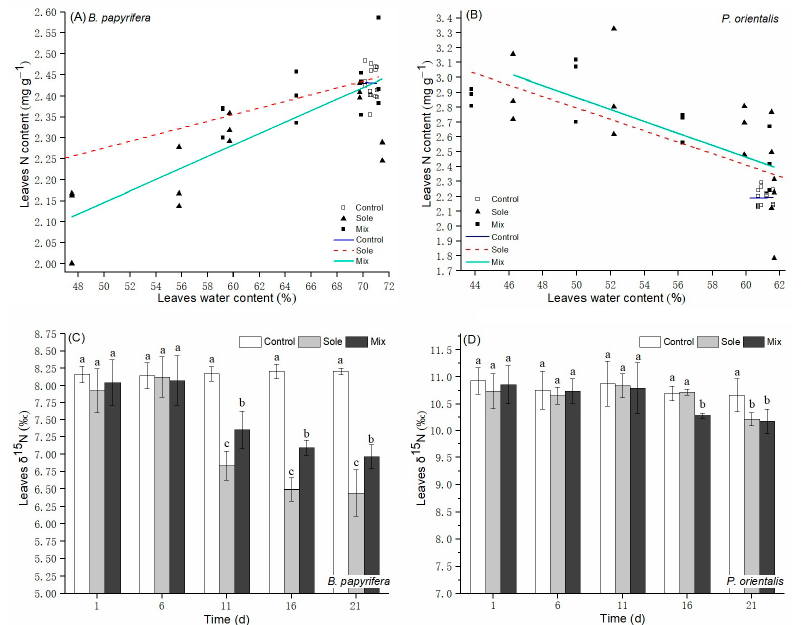
Figure 5. The leaves’ N content relative to water content in B. papyrifera ( A ) and P. orientalis ( B ). Curve fits in the graphs are separate linear regressions. Leaves’ δ 15 N value in B. papyrifera ( C ) and P. orientalis ( D ). Letters denote significant differences among different planting and treatment modes ( p < 0.05).